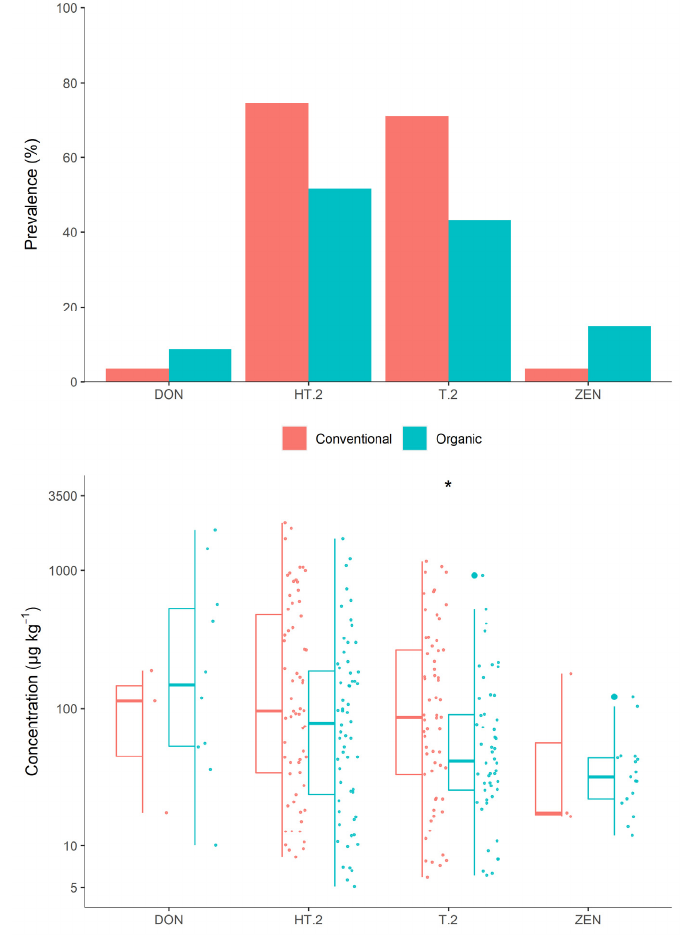
Figure 4. Prevalence of each mycotoxin ( top ) and the distribution of detected levels ( bottom ), by type of farming system .